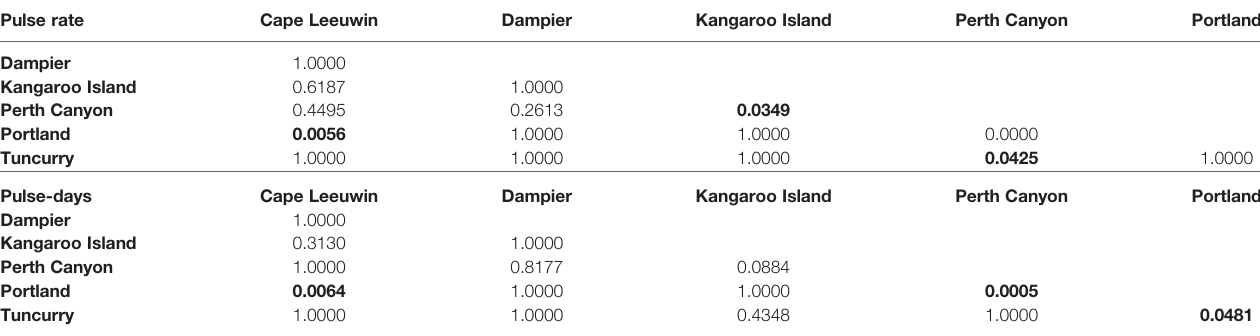
TABLE 3 | Kruskal-Wallis and post hoc Dunn test comparisons for differences in pulse rates per year (KW Chi-squared=28.79, df=5 and p= >0.01) and pulse-days per year (KW Chi-squared=21.76, df = 5, p = >0.01) between Australian sites with p value displayed. Pulse rate